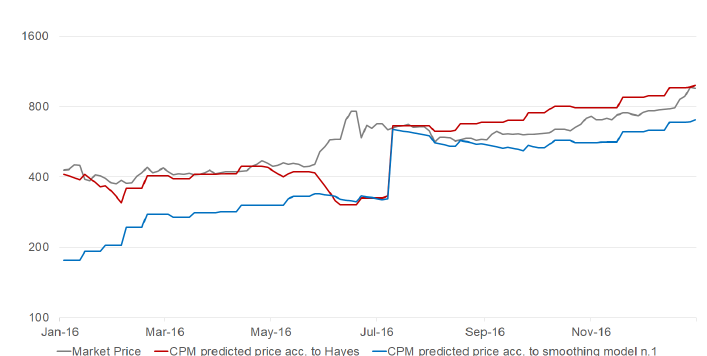
Figure 4. A sudden jump can be seen just before August 2016, highlighting the drawback of cost of production model. Logarithmic